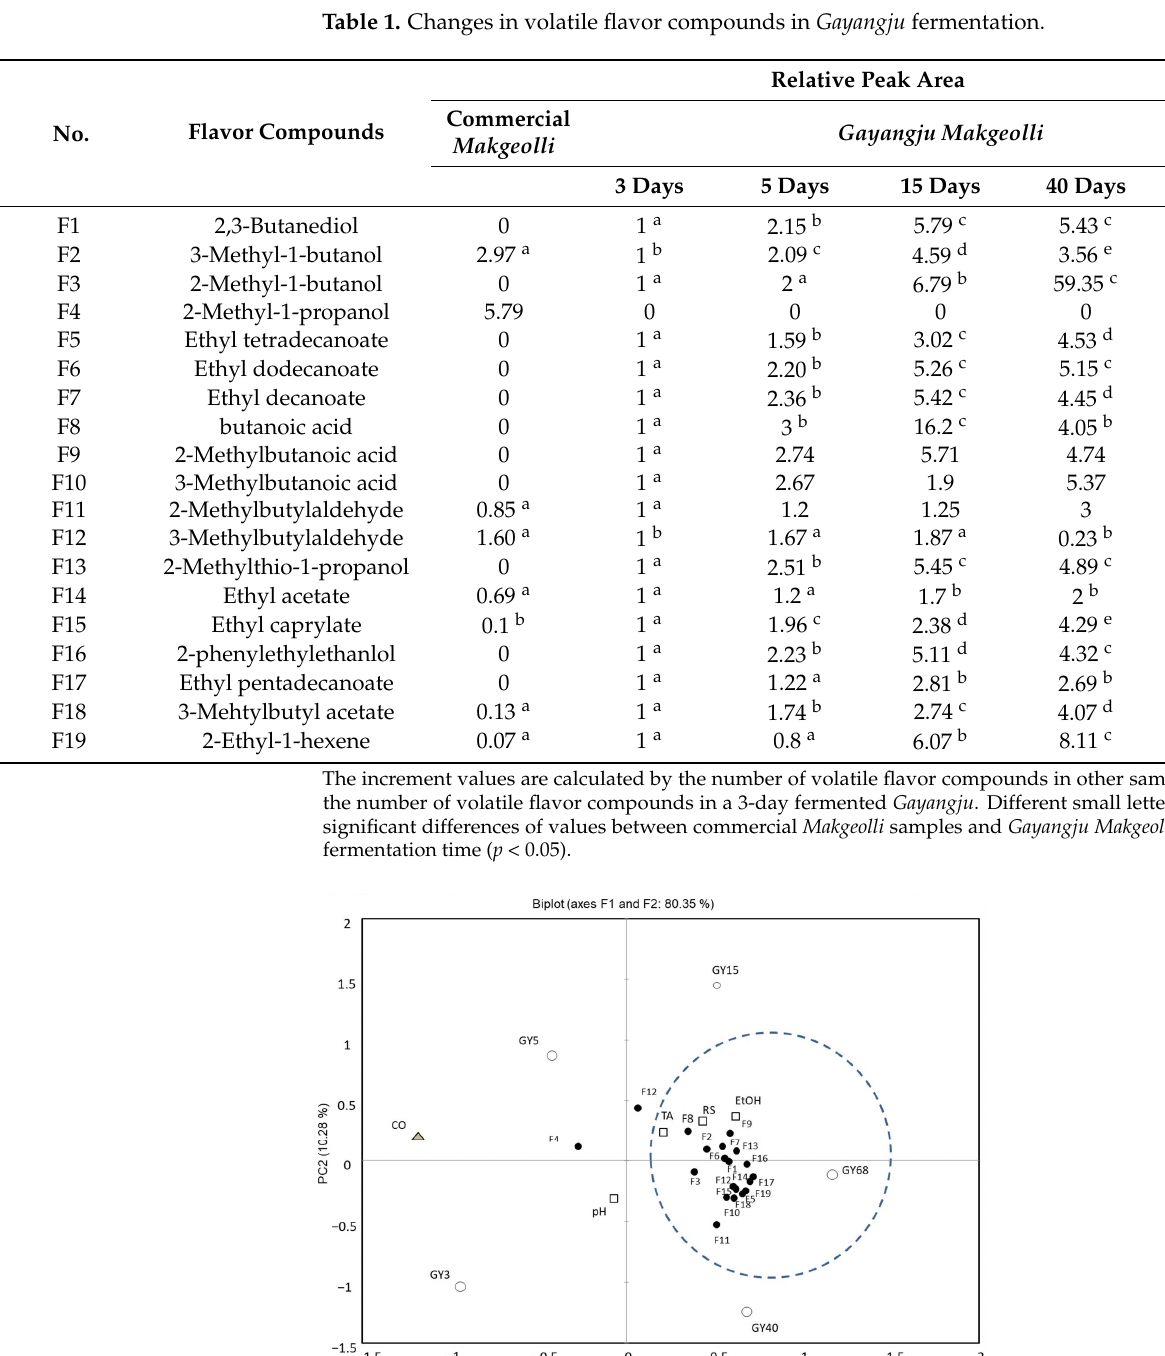
Figure 6. Biplot of the principal component analysis of volatile compounds from Korean traditional fermented makgeolli , Gayangju . pH, TA, RS, and EtOH indicate final pH, total acidity, soluble sugar, reducing sugar, and ethanol, respectively (□); The codes for flavor compounds (●) are defined in Table 1; As fermented Gayangju ( , GY), GY3, GY5, GY15, GY40, and GY68, indicate samples of different fermentation time of Gayangju . CO ( ) indicates commercial Makgeolli .